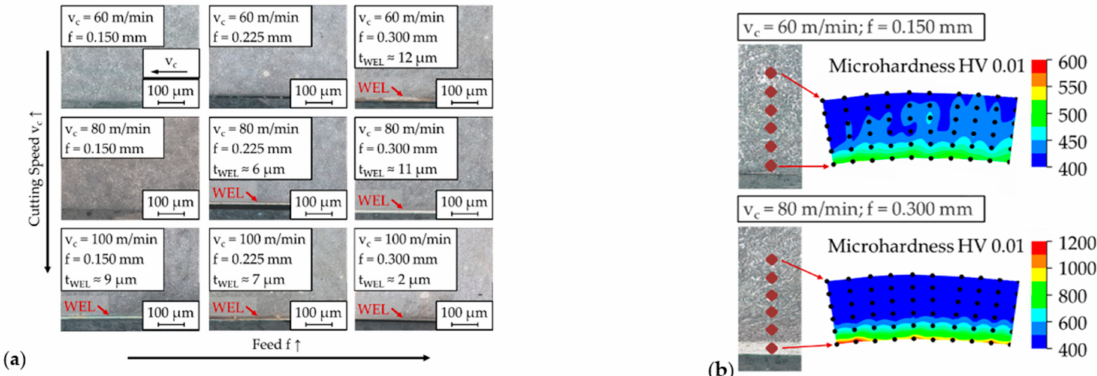
Figure 2. Surface layer analysis of drilled specimen ( a ) Micrographs ( b ) Microhardness